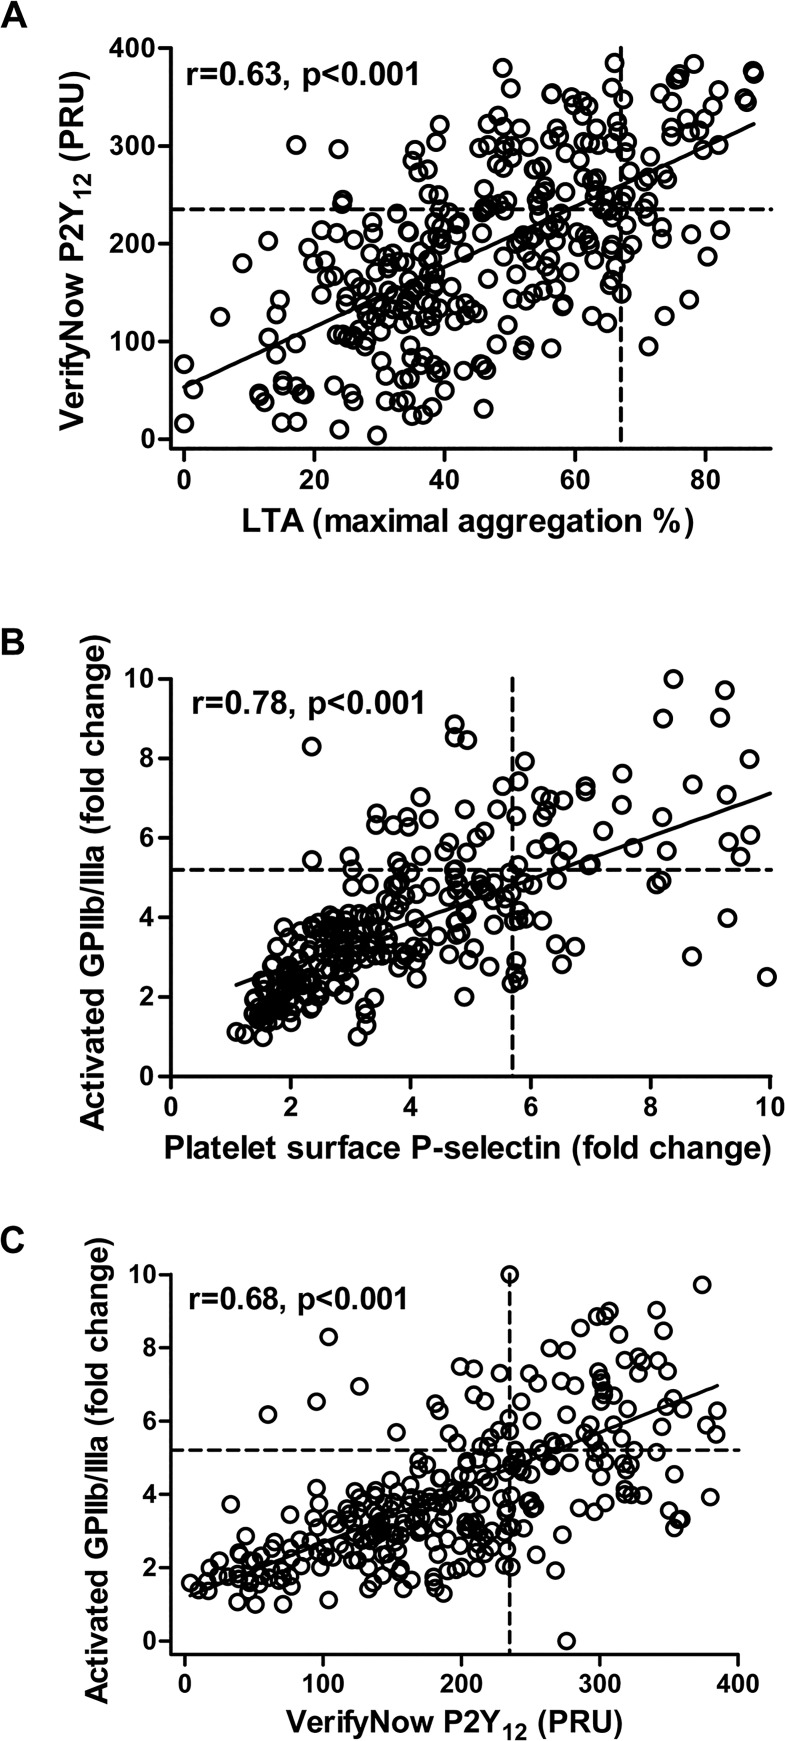
Correlations of adenosine diphosphate (ADP)-induced platelet aggregation and activation.
(A) Scatter plot showing ADP-induced platelet reactivity by light transmission aggregometry (LTA; x-axis) vs. platelet reactivity by the VerifyNow P2Y12 assay (y-axis). Circles represent individual measurements. Cut-off values for high on-treatment residual platelet reactivity are indicated by the dotted lines. PRU, P2Y12 Reaction Units. (B) Scatter plot showing ADP-induced platelet surface P-selectin expression (x-axis) vs. ADP-induced activated glycoprotein (GP) IIb/IIIa (y-axis). Circles represent individual measurements. Cut-off values for high P-selectin and high GPIIb/IIIa are indicated by the dotted lines. (C) Scatter plot showing platelet reactivity by the VerifyNow P2Y12 assay (x-axis) vs. ADP-induced activated glycoprotein (GP) IIb/IIIa (y-axis). Circles represent individual measurements. Cut-off values for high on-treatment residual platelet reactivity and high GPIIb/IIIa are indicated by the dotted lines. PRU, P2Y12 Reaction Units.